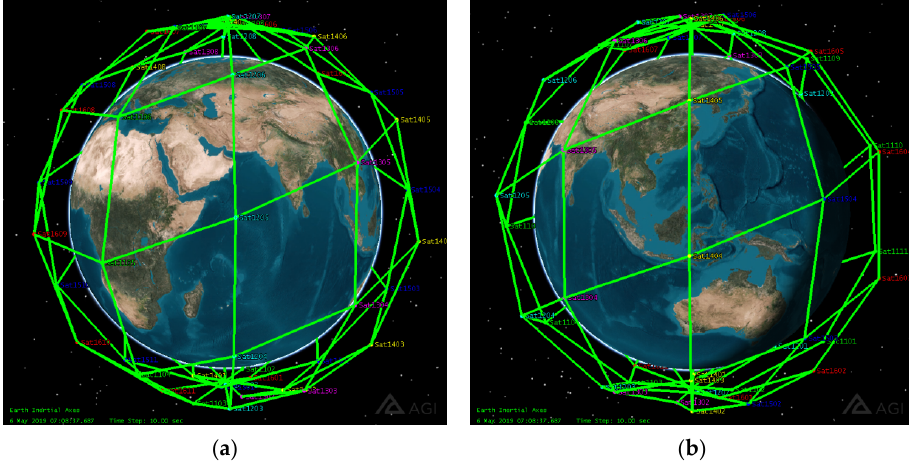
Figure 5. Three-dimensional plan of the satellite Internet of Things. ( a ) Observation point of Sat1205; ( b ) Observation point of Sat1404.